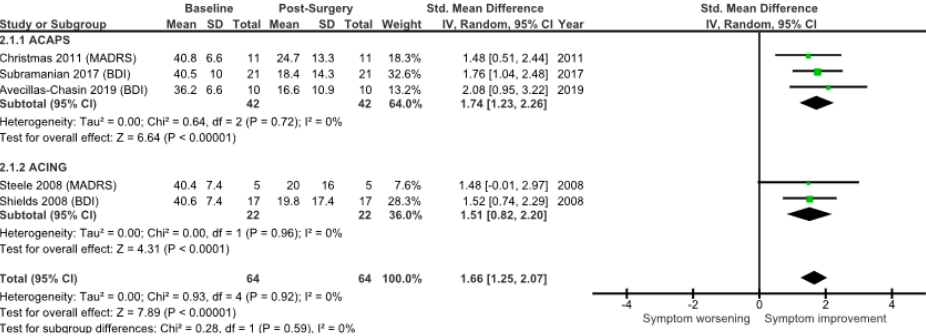
Figure 4. Standardised mean difference in depression scores pre- and post-ablative surgery for ACAPS and ACING. Only patients where individual patient data are available are included. The mean change for each study is represented by a green box. More powerful studies are indicated by a larger sized box, and they contribute to the pooled result to a greater degree